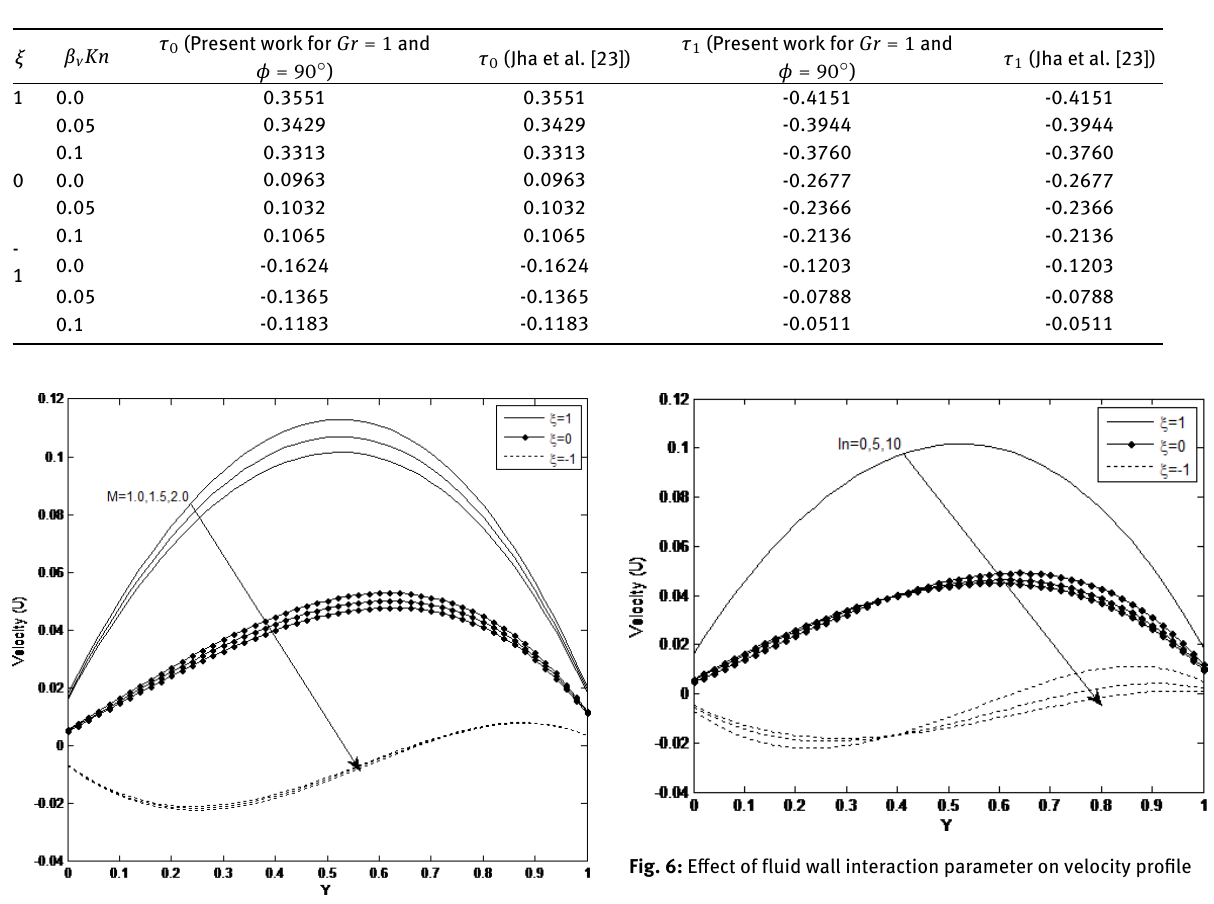
Fig. 4: Effect on Hartmann number on velocity profile